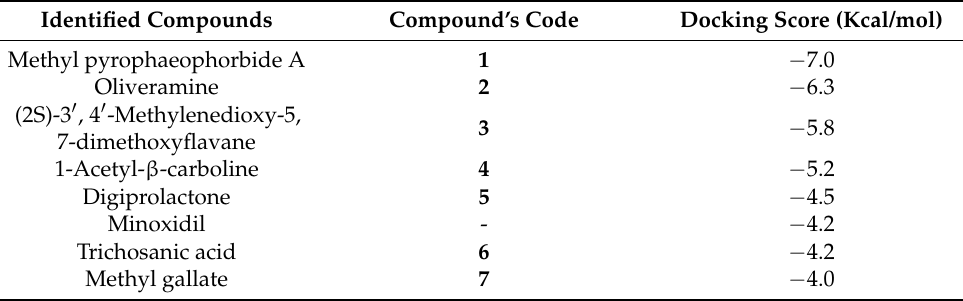
Table 2. Docking scores of minoxidil and identified compounds in LC-MS with